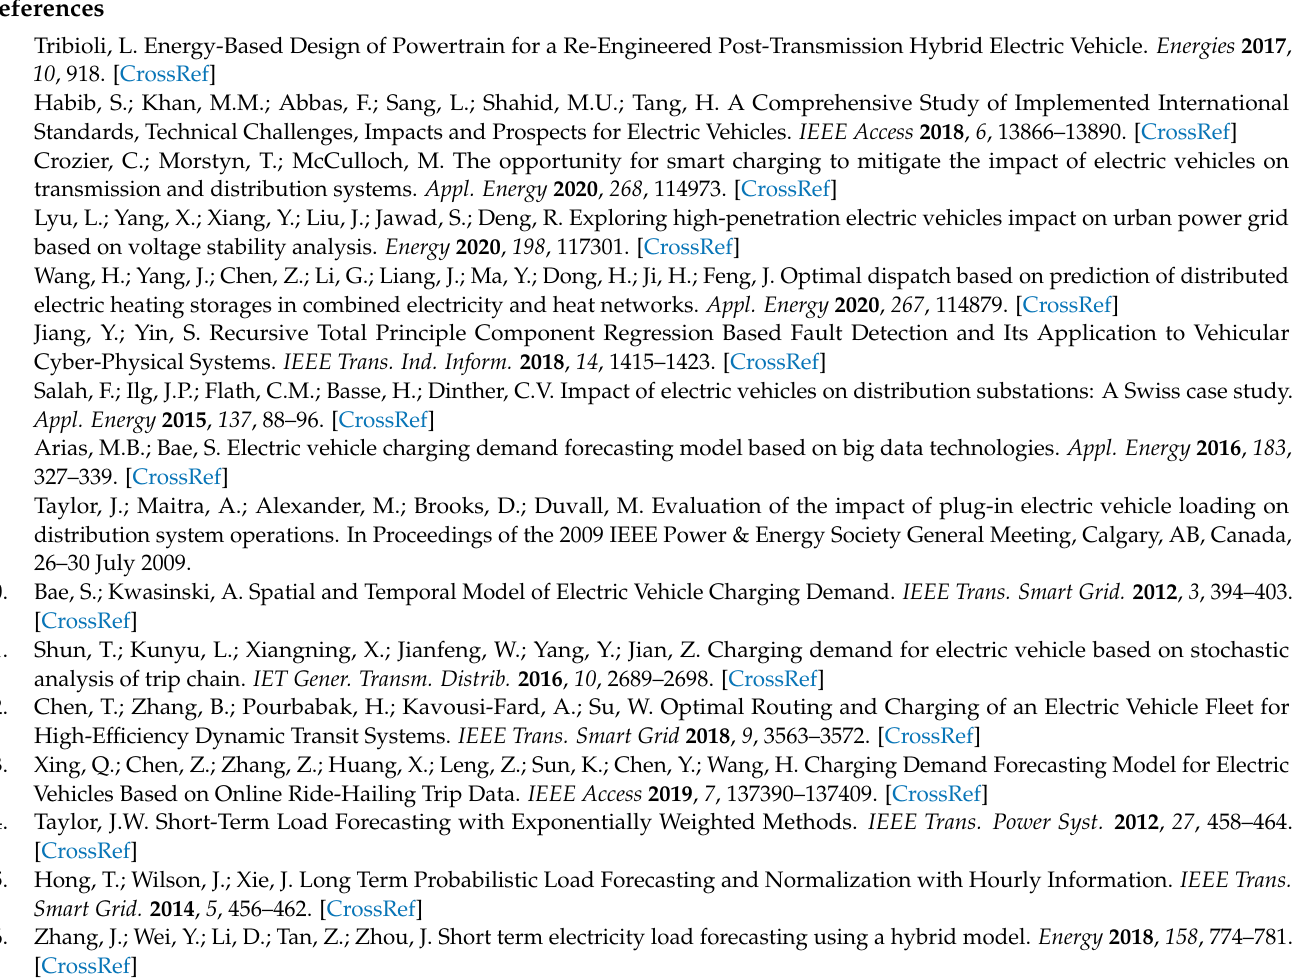
Figure A7. TCN model architecture.